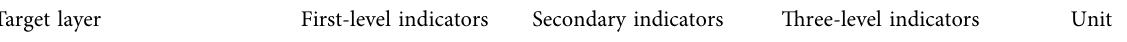
Table 2: Ideal values and weights of ecocarrying capacity indicators for UK urban